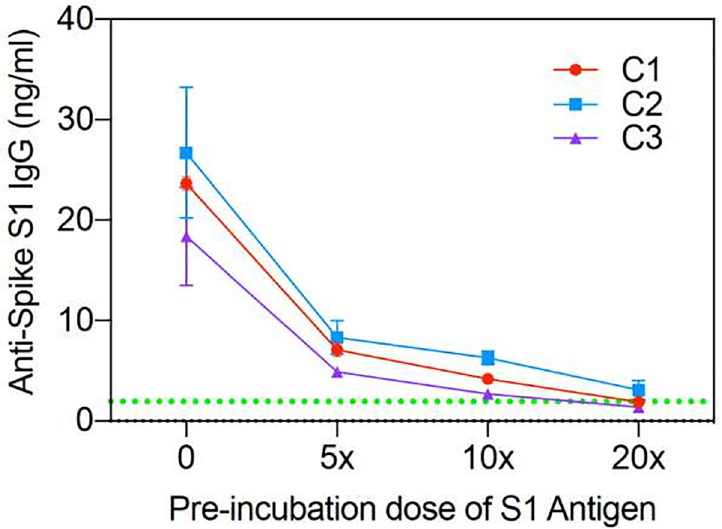
Fig 3. Competition assay of three COVID-19 patients: C1, C2, and C3. Varying amounts of exogenous anti- SARS-CoV-2 IgG added to saliva of 3 different recovered COVID-19 patients.